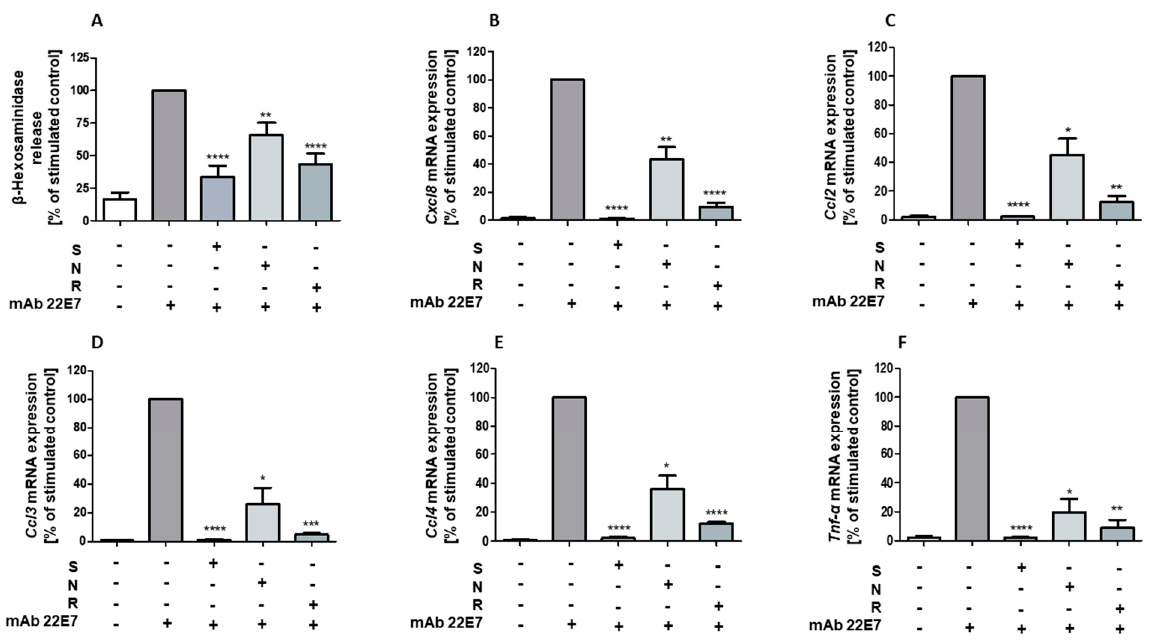
Figure 2. Degranulation and chemokine expression in hiMC following treatment with stattic, nobiletin, and resveratrol. Release of β -hexosaminidase ( A ) ( n = 9) and mRNA expression of Cxcl8 ( B ) ( n = 4), Ccl2 ( C ) ( n = 3), Ccl3 ( D ) ( n = 3), Ccl4 ( E ) ( n = 3), and Tnf- α ( F ) ( n = 3) by hiMC following treatment with 60 μ M of stattic (S), 45 μ M of nobiletin (N), or 50 μ M of resveratrol (R), or corresponding concentrations of the vehicle DMSO (control). Cells were stimulated by Fc ε RI crosslinking using 100 ng/mL of mAb 22E7 for 5–90 min ( A ) and 90 min ( B – F ). Results are shown in % of stimulated control. Values are mean ± SEM. * p < 0.05; ** < 0.01; *** p < 0.001; **** p < 0.0001.